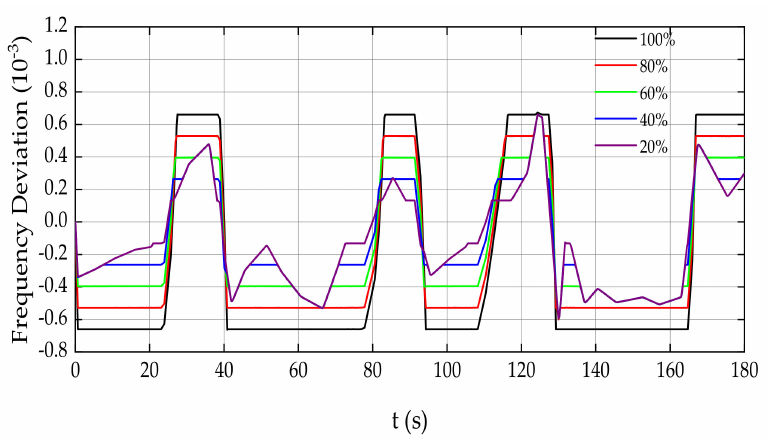
Figure 7. Continuous load disturbance curve.